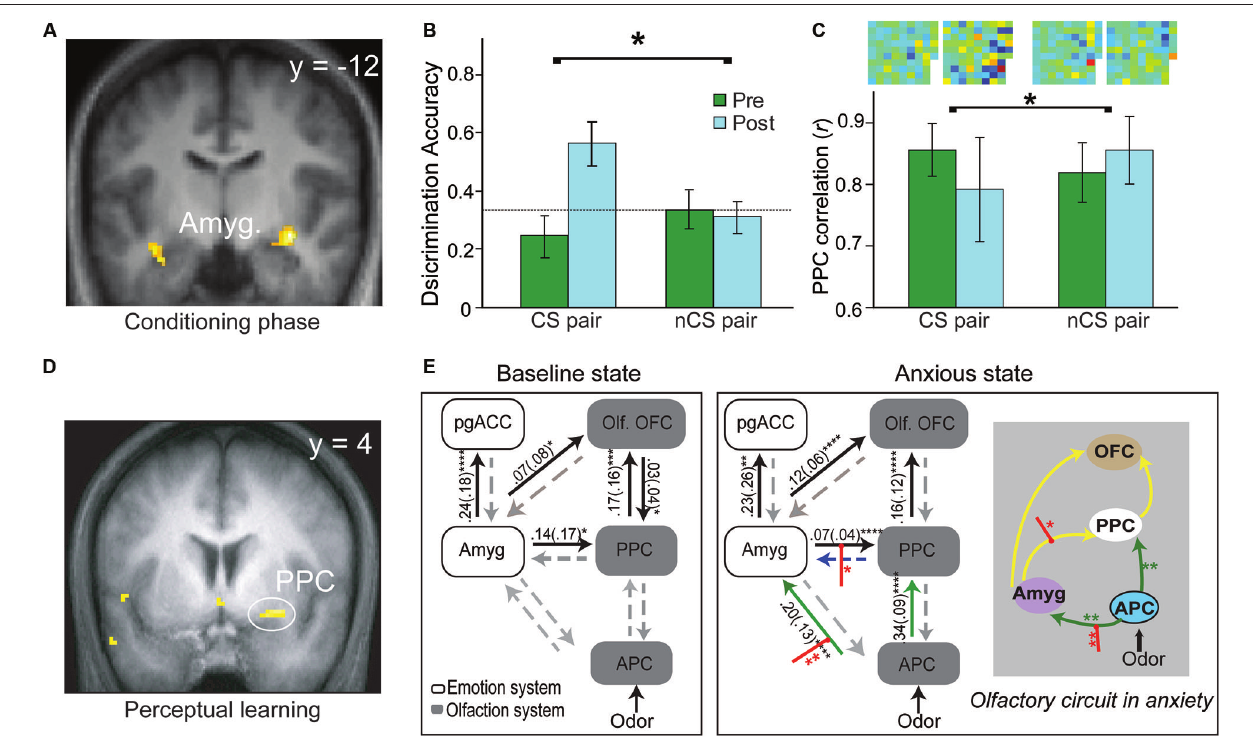
(E) The olfactory sensory pathway adapts readily with induced anxiety, characterized by strengthened APC efforts to amygdala and PPC, and amplified amygdala efferent to the PPC. This olfactory circuitry reorganization is accompanied by a significant negative shift in perceived pleasantness of odors (not shown here). This enhanced amygdala-olfactory-cortex connection may facilitate the transfer of learning from the amygdala to the olfactory cortex. Yellow lines represent intrinsic connections initially significant, green lines those that become significant in anxiety and red intercepting lines modulation by odors in anxiety. OFC = orbitofrontal cortex; PPC = posterior piriform cortex; pgACC = pregenual anterior cingulate cortex; Amyg. = amygdala; olf. = olfactory; APC = anterior piriform cortex. Panels A–C are adapted from Li et al. (2008a), Panel D from Li et al. (2006) and Panel E from Krusemark et al.